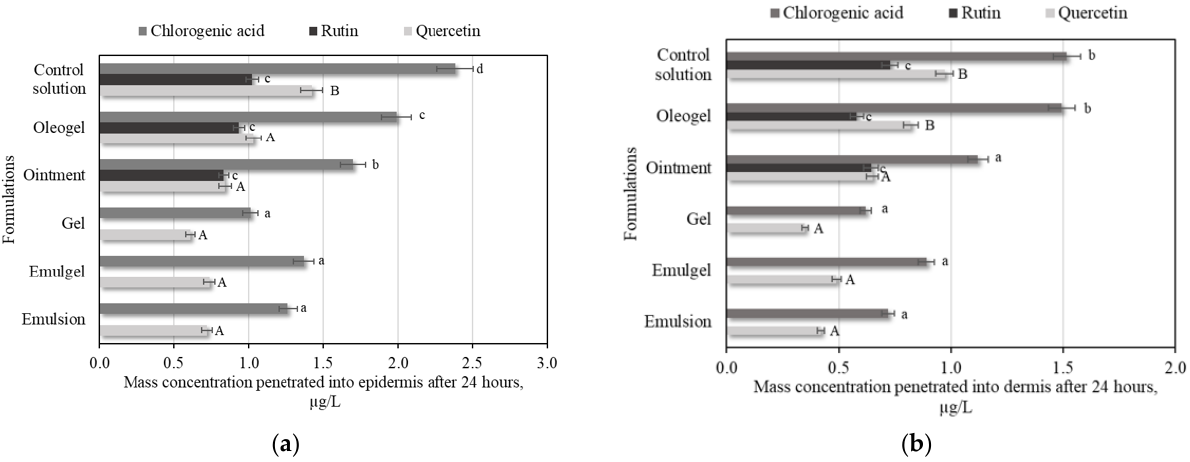
Figure 4. Results of penetration study: ( a ) Permeation of the mixture of chlorogenic acid, rutin, quercetin, (+)-catechin, and (−) -epicatechin standard solution from semi-solid forms into the epidermis after application for 24 h; ( b ) Permeation of the mixture of chlorogenic acid, rutin, quercetin, (+)-catechin, and (−) -epicatechin standard solution from semi-solid forms into the dermis after application for 24 h. Uppercase and lowercase letters indicate statistically significant differences between the amount of phenolic compounds that penetrated into the skin layers from semi-solid pharmaceutical forms ( p < 0.05).